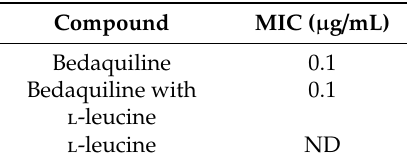
Table 1. Minimum inhibitory concentrations (MICs) of bedaquiline and bedaquiline with l -leucine formulations against Mycobacterium tuberculosis mc 2